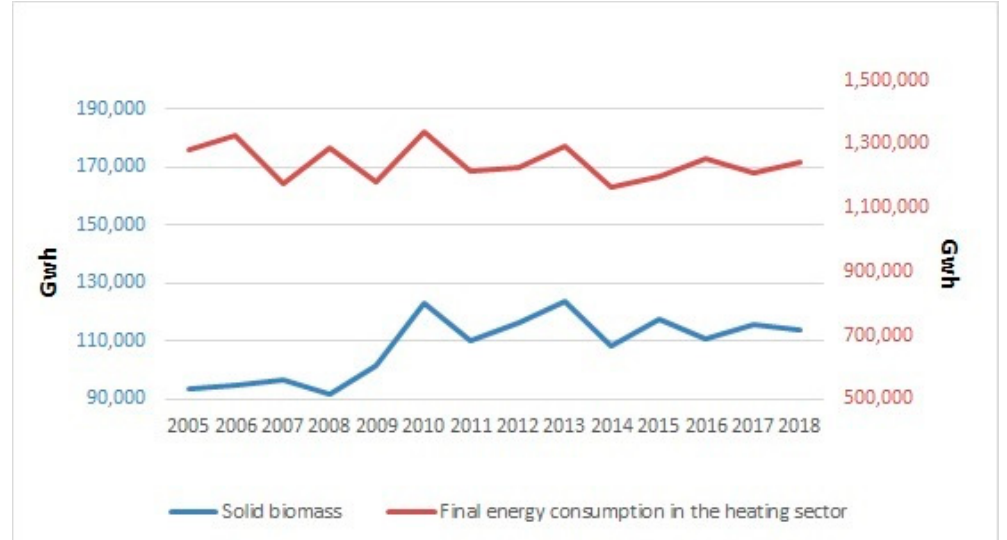
Figure 1. Final energy consumption for heating purposes in Germany, total and covered by solid biomass (data from [10,11]).